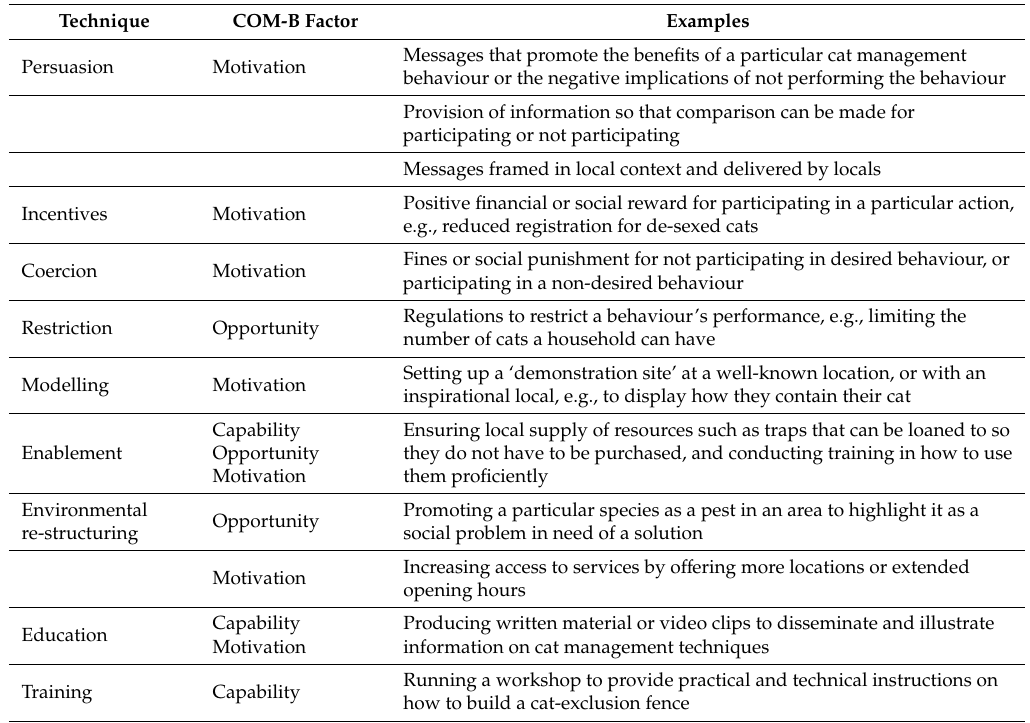
Table 3. Examples of intervention techniques for cat management and the Capability, Opportunity, Motivation-Behaviour (COM-B) behavioural factors they best match (after [66]). Technique COM-B Factor Examples